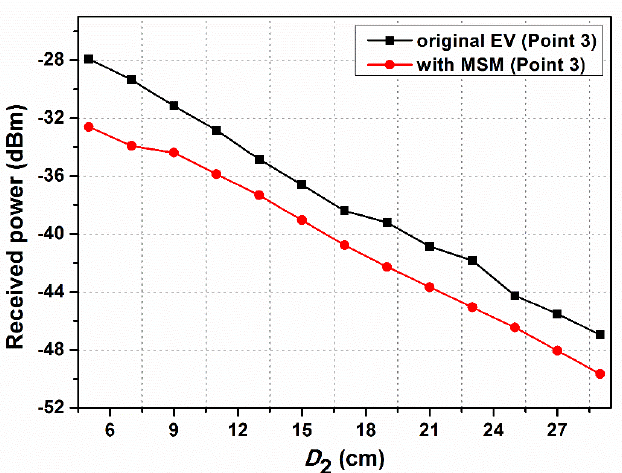
Figure 11. Magnetic field of the EV with and without MSM at point 3.